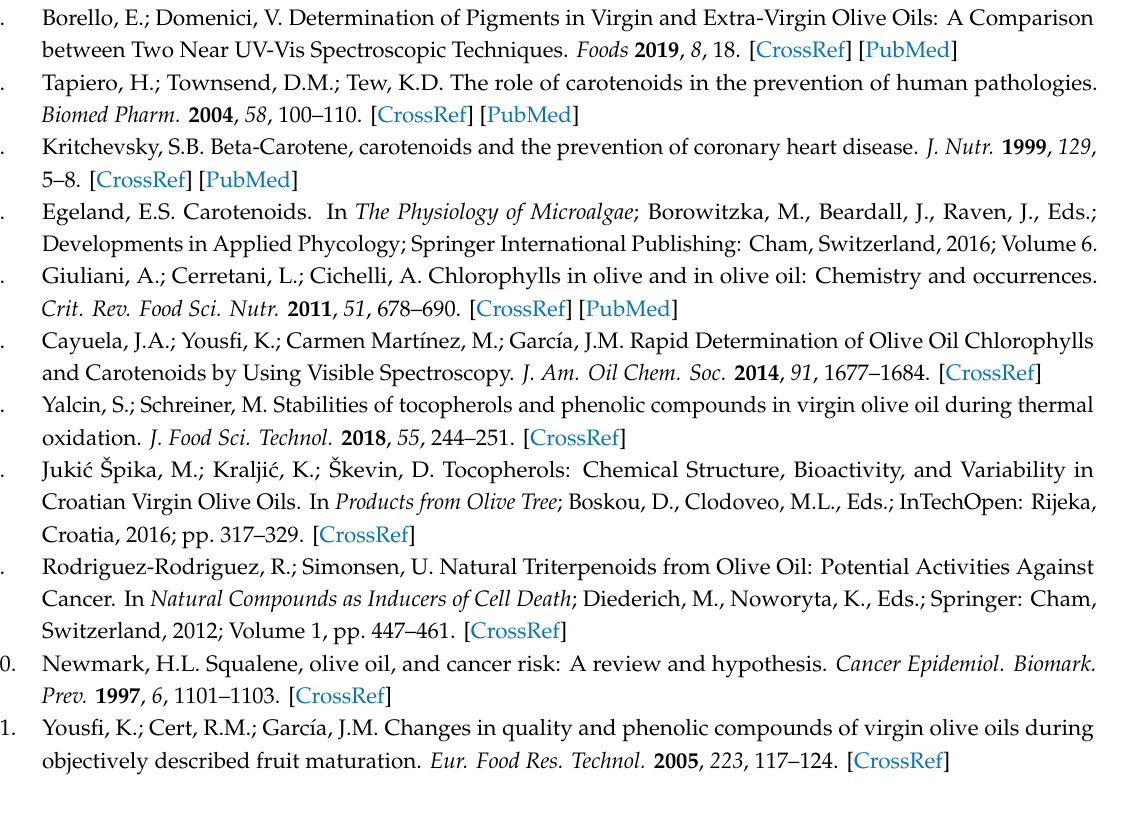
Figure S1: Sampling Zones of the island of Lesvos, Figure S2: Pheophytin and Pyropheophytin Spectra acquired ( a ) from Hornero- Mendez et. al. [18] and ( b ) our HPLC-DAD system, Table S1: Categorization of Samples regarding cultivation and olive-oil production parameters (Full), Table S2: Peak Symmetry using the gradient elution program, for lutein, chlorophyll and